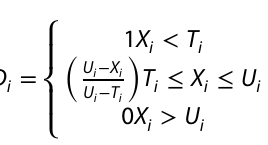
Fig. 4 Contour plots of NOx for FIP and CR at different levels of SOI and EGR (VCR